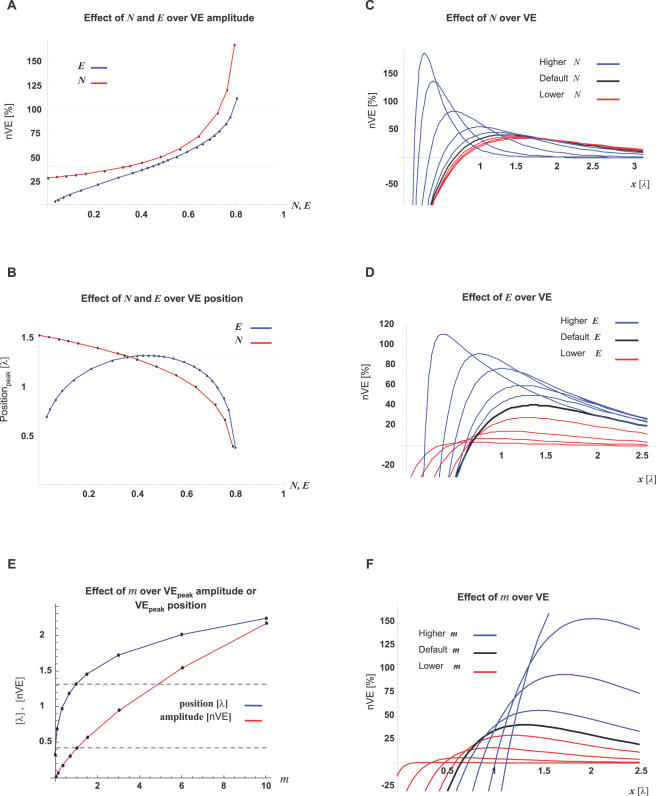
VE can be generated by a wide range of parameters.One-dimensional mapping (i.e. one parameter at a time) of the fraction of the non-conductive cross-section (N) and the fraction of the ER cross-section of the total cross-section (E). All other parameters followed the default parameters (Table 2). VE amplitude is presented as percent of the EPSP amplitude at the position of the VE peak (nVE). Note that E and N describe each a fraction of the total cross-section, therefore their range is limited by: {N+E≤1}. (A) Levels of nVE-peaks are presented against different N (red trace) or E (blue trace) values. (B) The positions of the VE-peak are plotted against different N (red trace) or E (blue trace). (C,D) VE patterns are sampled across the range of E and N, tested. Traces generated with parameters above or below the default values are presented in blue or red, respectively. (E) Amplitude and position of the VE-peaks are presented against different m values. The red trace represents amplitude (nVE units). The Blue trace represents the position (λ units). Gray dashed lines mark the amplitude and position of the default value (m = 1). (F) VE patterns are sampled across the range of m, tested. Traces generated with m above or below the default value are presented in blue or red, respectively.